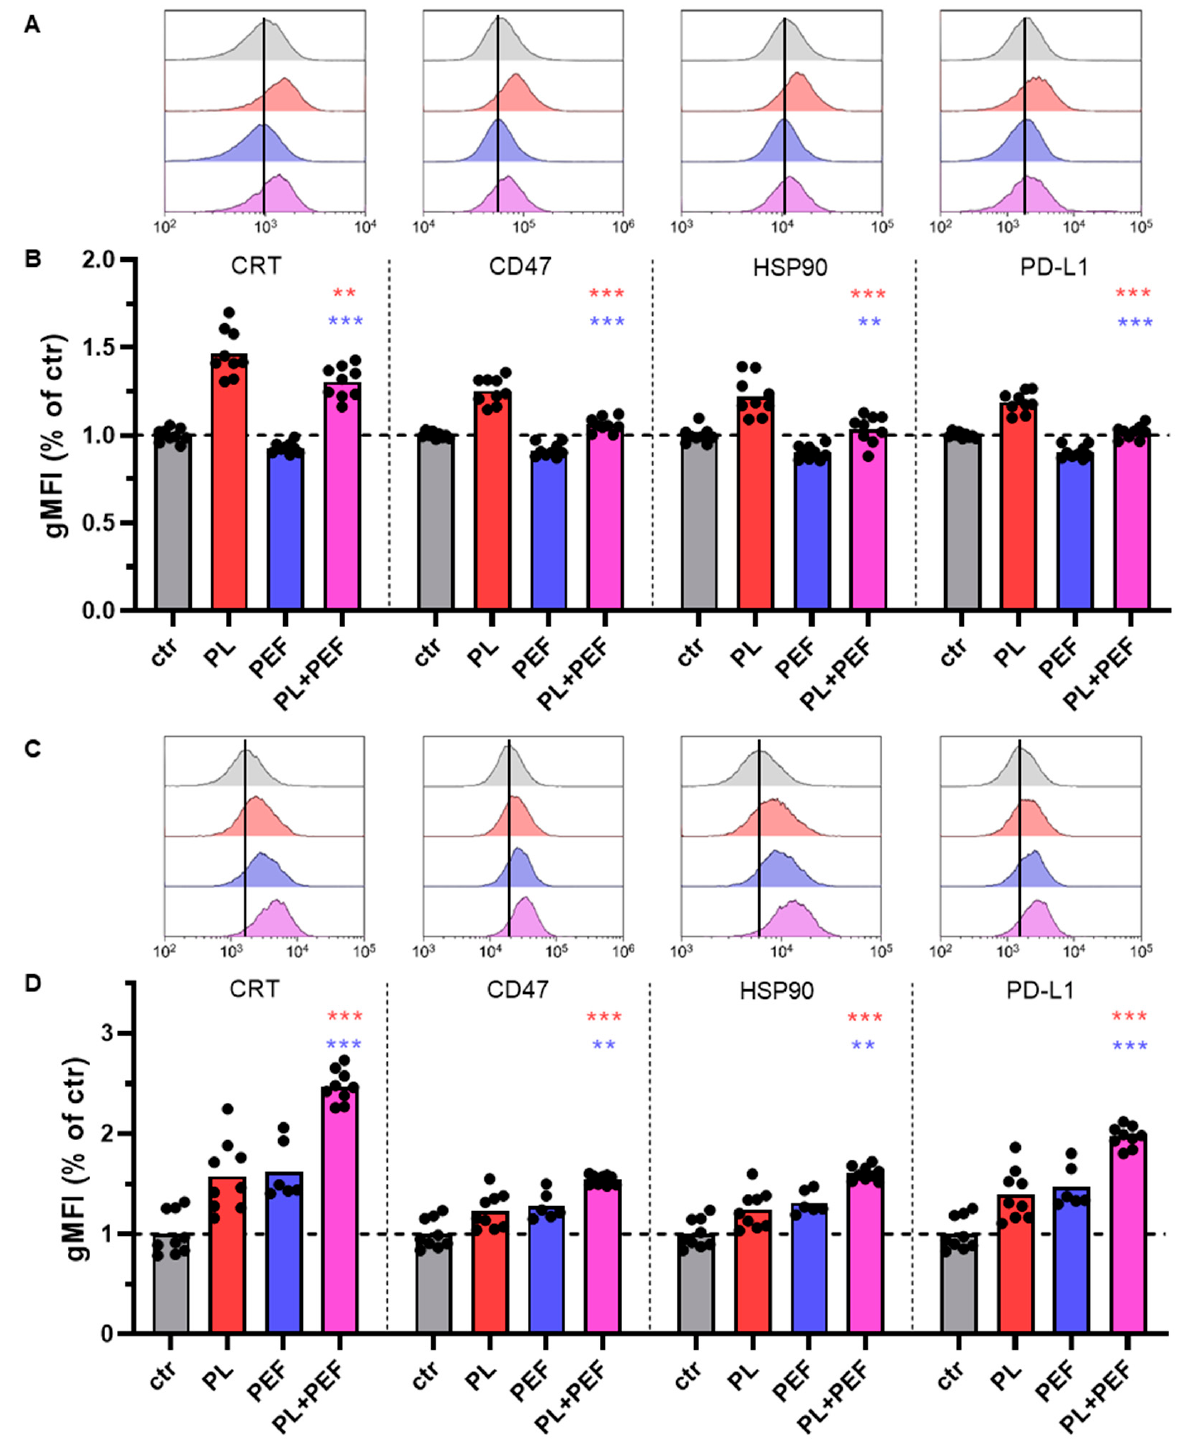
Figure 7. Effects on ICD markers of Jurkat and TK6 cells in RPMI after plasma and PEF treatment. The effect on the cell surface markers CRT, CD47, HSP90, and PD-L1, indicating ICD, was analyzed 24 h after treating Jurkat ( A , B ) and TK6 ( C , D ) cells. Data are shown as one representative ( A , C ) or mean from three independent experiments with several replicates each ( B , D ). One-way ANOVA with Turkey’s multiple comparison test was performed (**: p < 0.01 and ***: p < 0.001). ctr: control; PL: plasma; PEF: pulsed electric field; ns: not significant; CD47: cluster of differentiation 47; PD-L1: programmed cell death ligand 1; HSP90: heat shock protein 90; CRT: calreticulin.